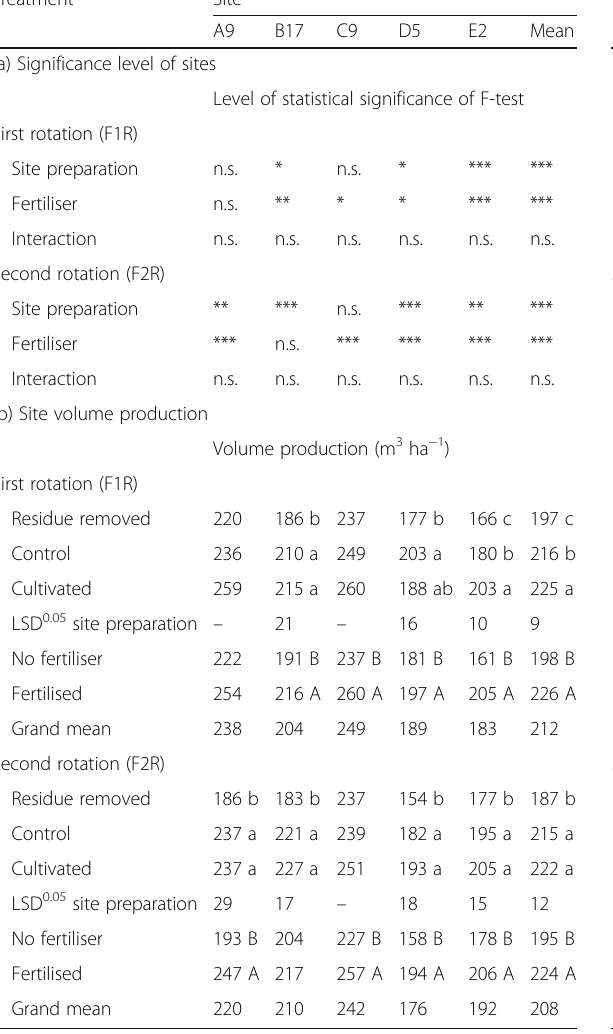
Table 3 ANOVA summary of (a) significance level of five individual sites and (b) volume production per site main treatments at age 10 years, on the first and second rotations for the first (F) trial series established in 1971 Treatment